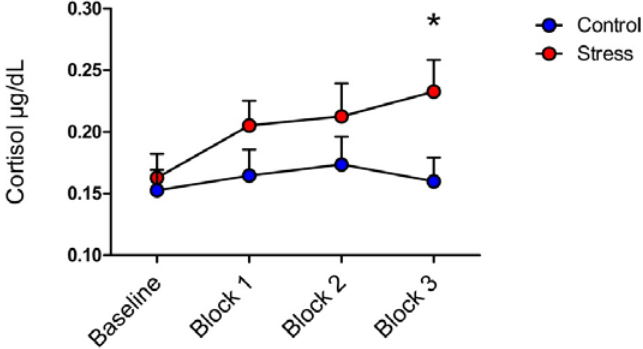
Figure 2. Cortisol levels for the two conditions at four time points. There was a